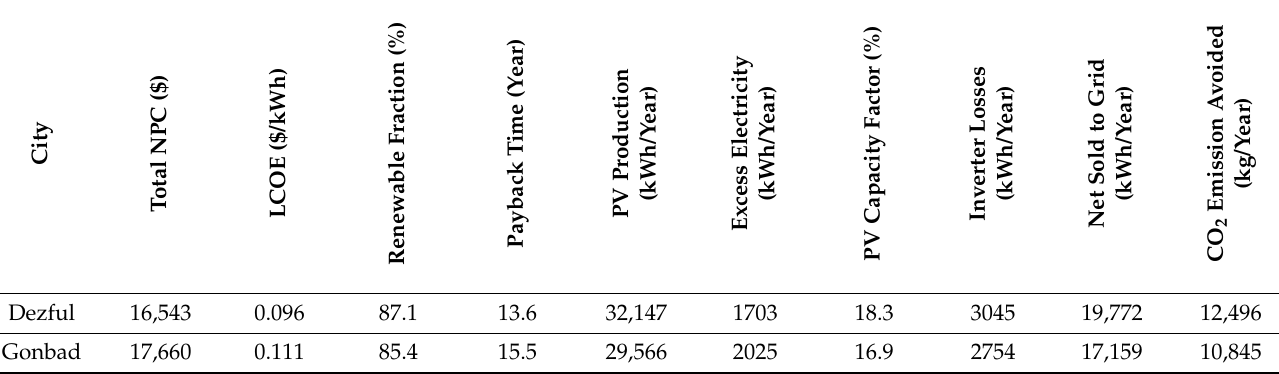
Table 9. The 0 ◦ slope decision-making